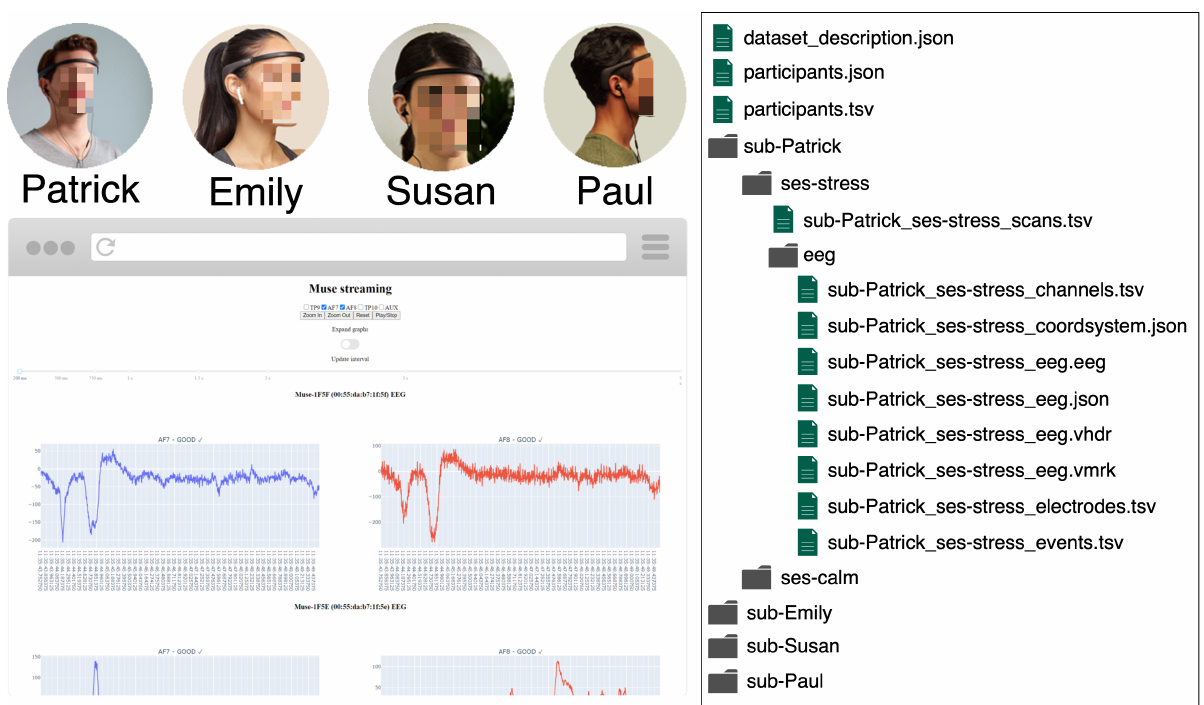
Figure 5. Solution designed for